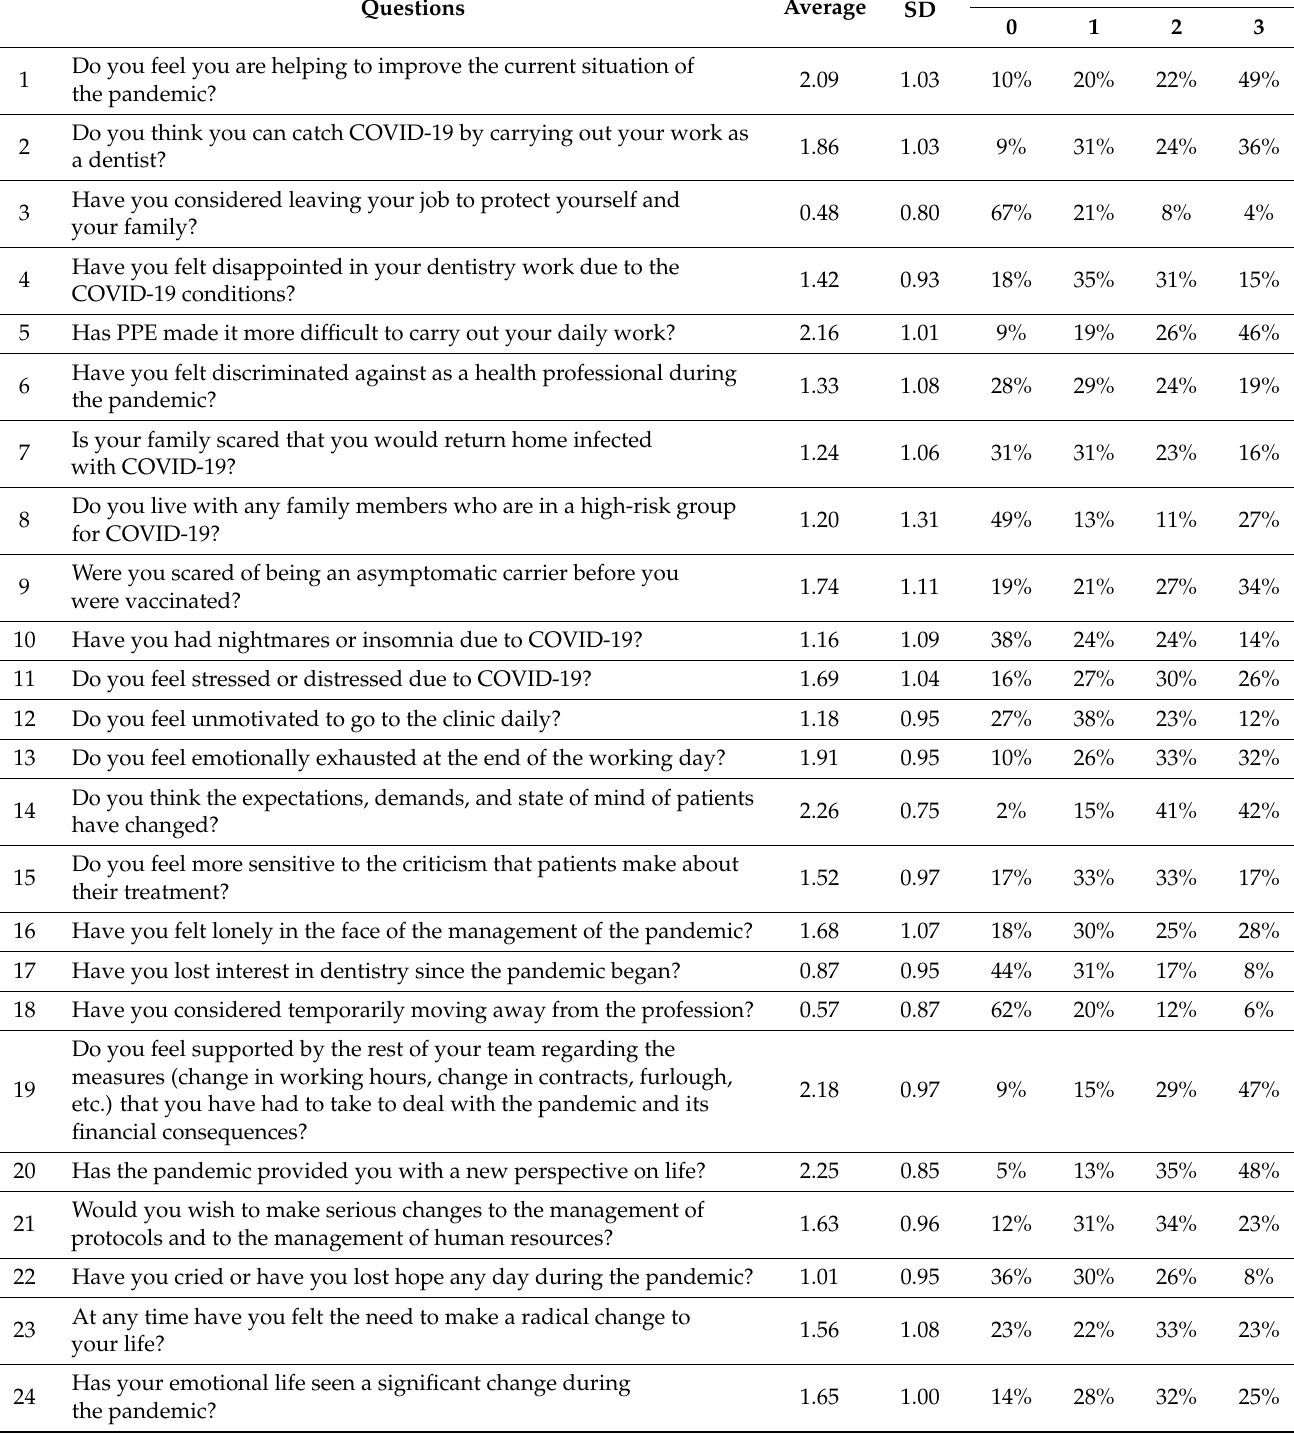
Table 2. Questionnaire on the emotional